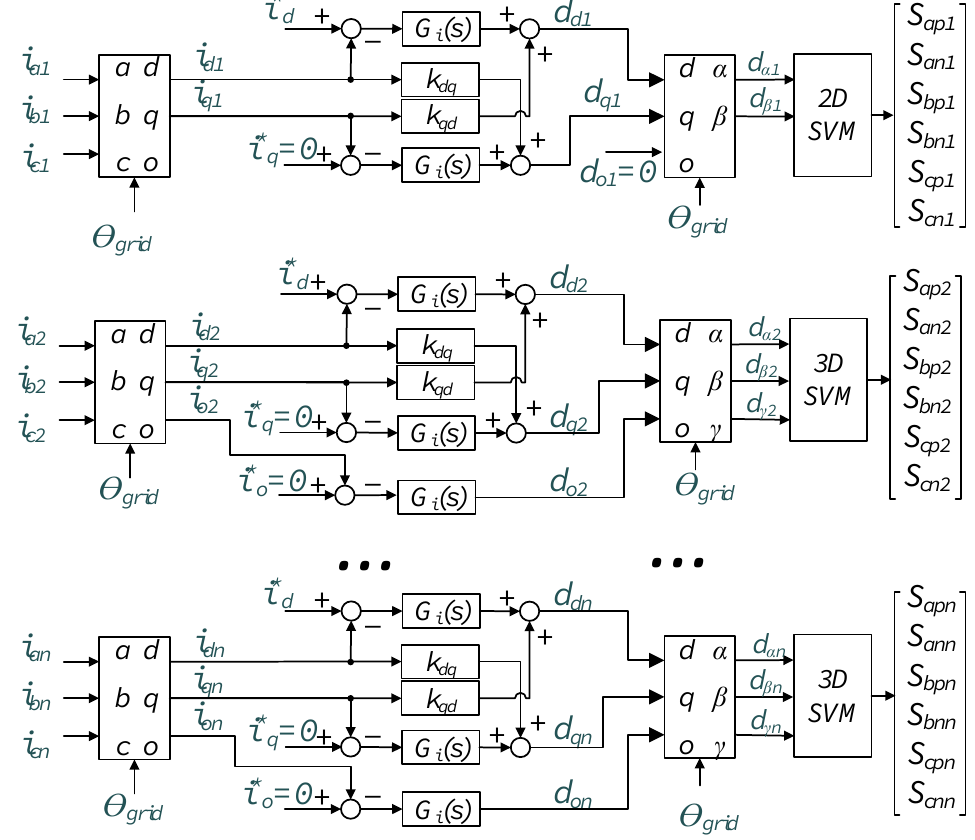
Figure 3. Scheme of the proposed control stage.